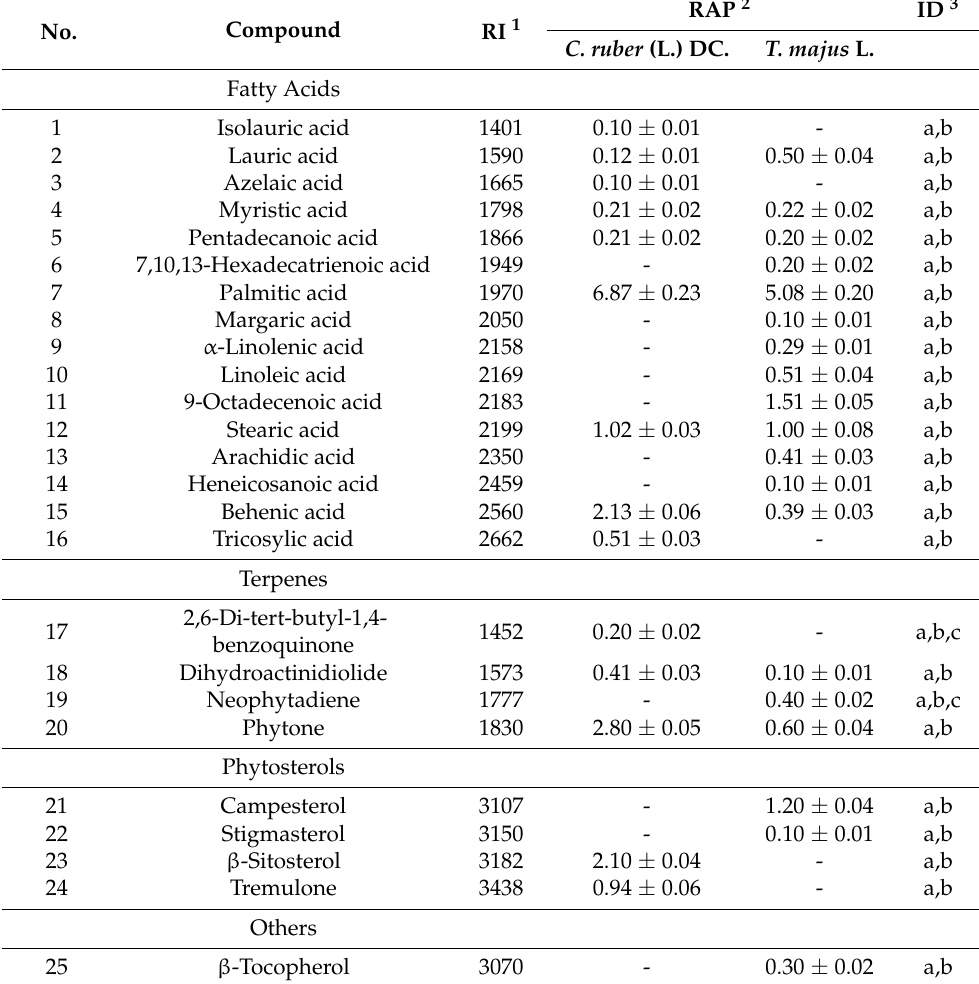
Table 1. Phytochemical profile of the n -hexane fractions of Centranthus ruber (L.) DC. and Tropaeolum majus L. extracts.